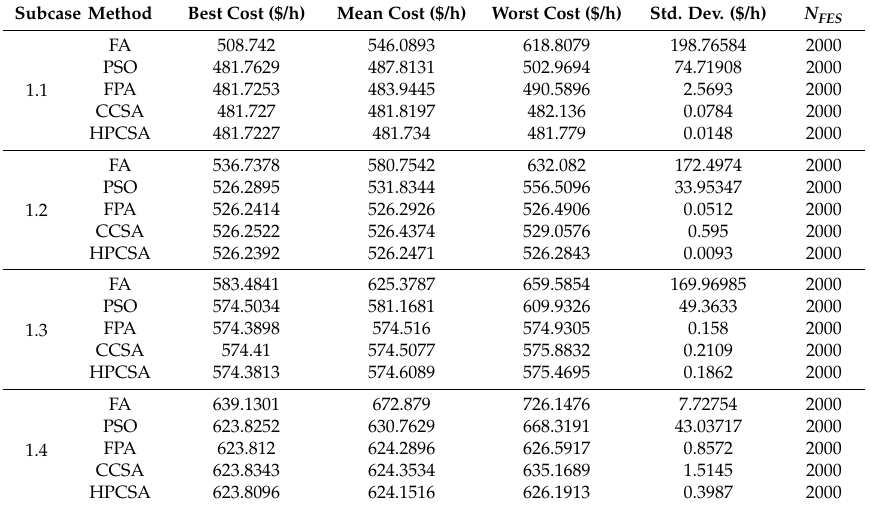
Table 2. The results obtained by Firefly algorithm (FA), particle swarm optimization (PSO), flower pollination algorithm (FPA), CCSA and the proposed high performance cuckoo search algorithm (HPCSA) for subcases of case 1.